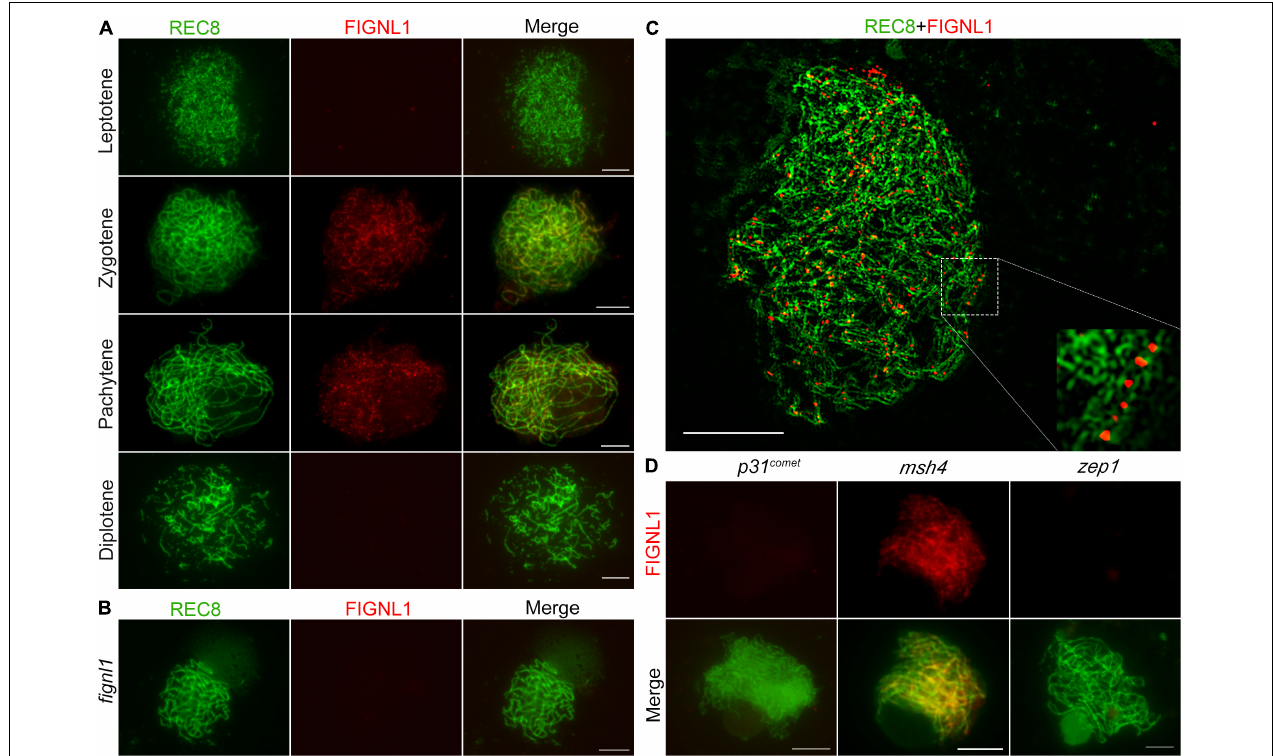
FIGURE 6 | FIGNL1 is a meiotic chromatin-associated protein. (A) Dual immunolocalization of REC8 (green) and FIGNL1 (red) in wild-type meiocytes from leptotene to diplotene. (B) Dual immunolocalization of REC8 and FIGNL1 in fignl1 . (C) FIGNL1 foci are located between two lines of REC8 signals. (D) Immunolocalization of FIGNL1 in p31 comet , msh4 and zep1 . Bars, 5 µ